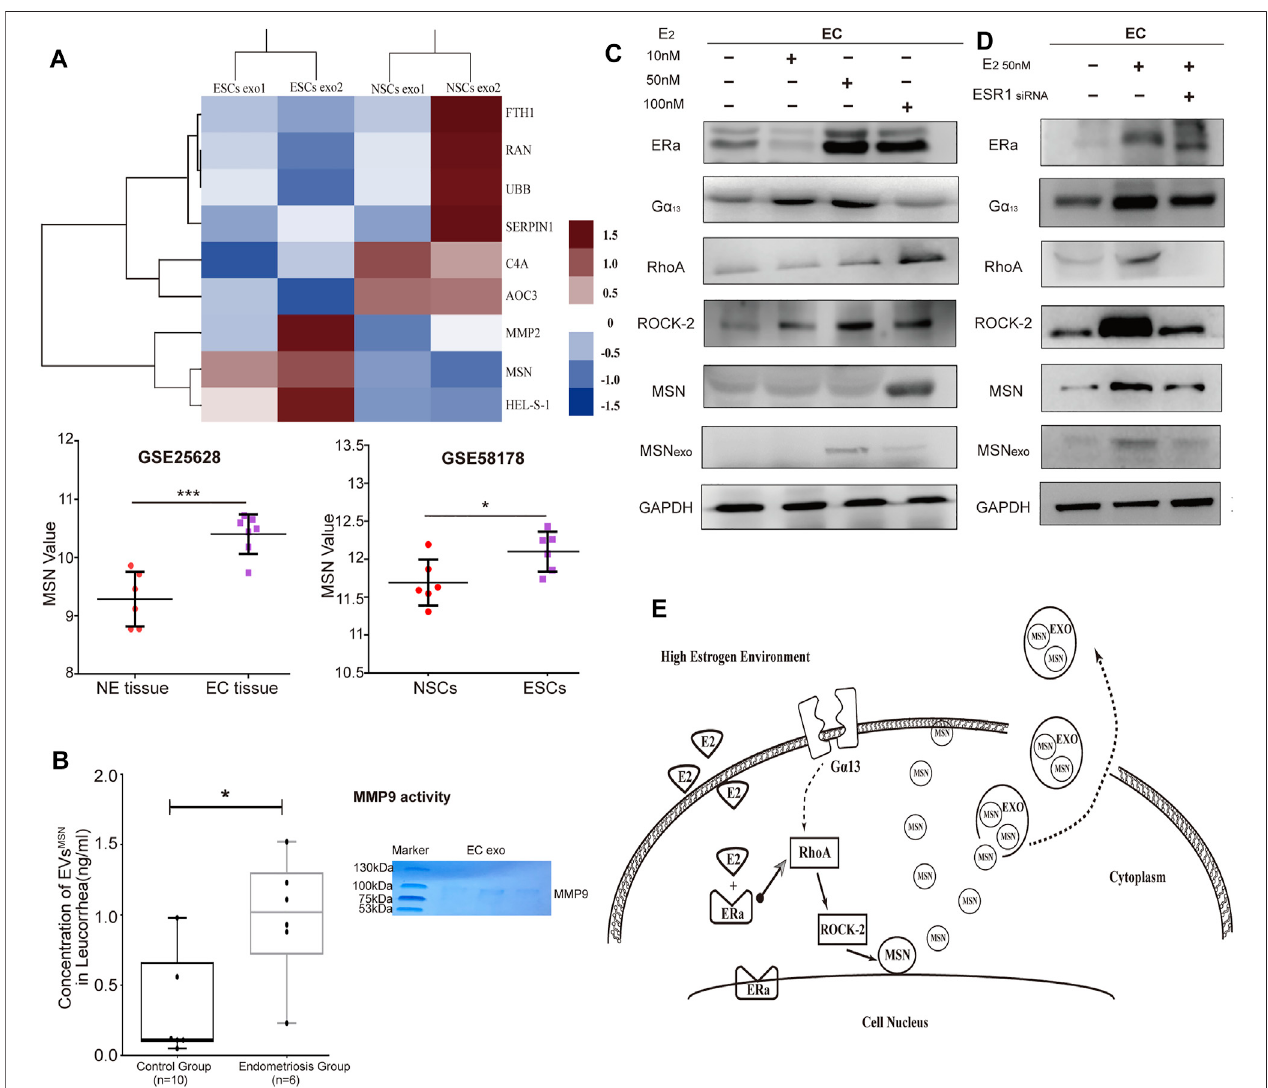
FIGURE3| Theproteomepro fi leofNSCs-andESCsexosomes. (A) Heatmapofsixsigni fi cantlyup-regulatedproteinsandthreedown-regulatedproteinsinNSCs exosomes ( n = 2) versus ECSs exosomes ( n = 2), with depletion depicted in blue and enrichment in red. GEO dataset for RNA high-throughput sequencing results of endometriosis (GSE25628 for tissue and GSE58178 for primary stromal cells),which showed thatMSN value inectopic endometrial tissues (primary stromal cells) were higher than those in the normal group (GSE25628, *** p < 0.001; GSE58178, * p < 0.05). (B) Elisa assay to detect the expression of MSN in vaginal secretion. Data were expressed as mean ± SEM, * p < 0.05. Acrylamide-gelatin electrophoresis detected the activity of MMP9 in EVs. (C) Three concentration of estrogenwas treated with NSCs. The expression of RhoA, ROCK-2, MSN, and G α 13 was tested by western blot. (D) Western blot analysis to assess ER α recruited RhoA/Rock-2/MSN signaling pathway, but G α 13 displayed no signi fi cant change. (E) The pattern diagram of Era/RhoA/Rock-2/MSN signaling.